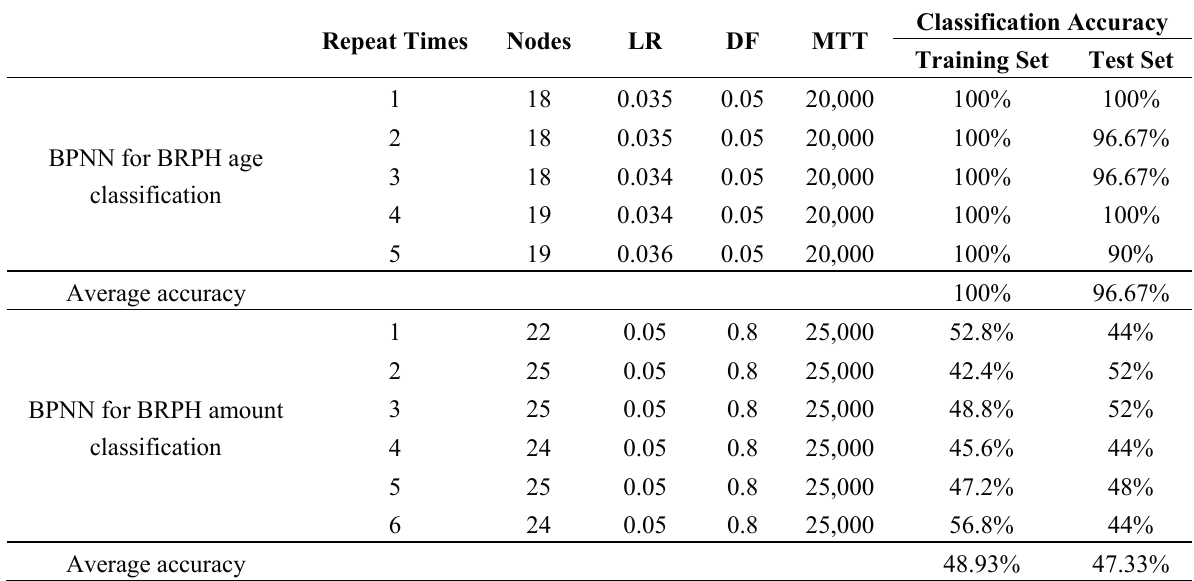
Table 5. BPNN for BRPH age and amount classification based on K-fold